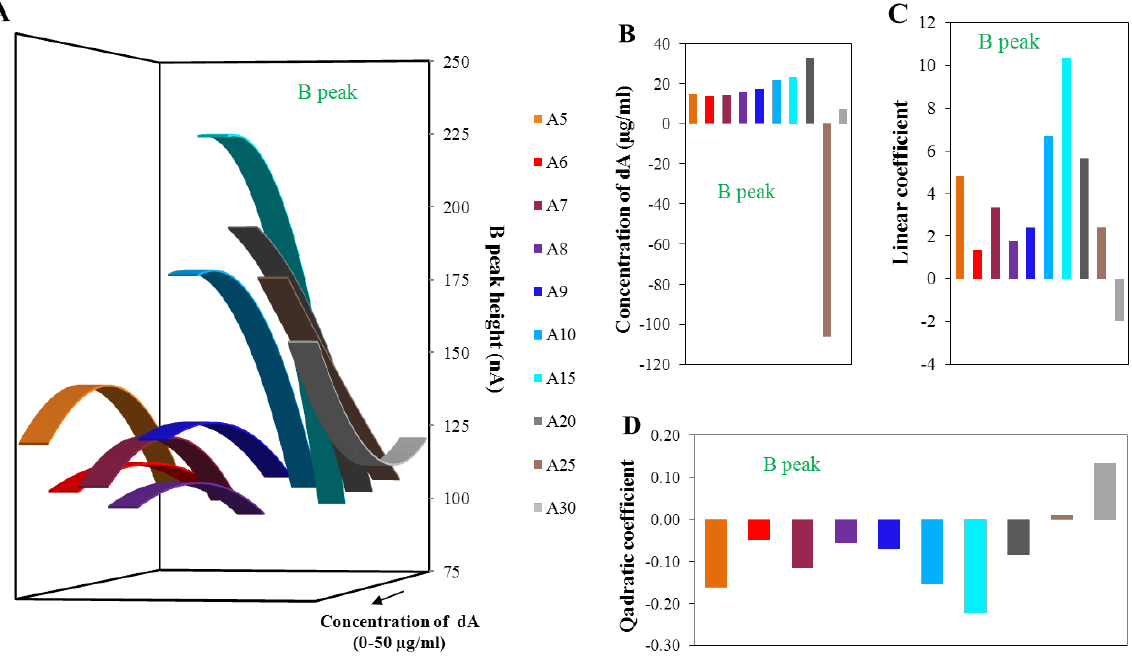
Figure 5. ( A ) Dependence of intensity of peak B related to the applied concentration of adenine nucleotides. The calculated quadratic dependencies are based on the measured data for peak B within the concentration range from 50 ng/mL to 25 µg/mL of adenine nucleotides before isolation process; ( B ) Determined concentration of adenine nucleotides relate to the local maxima/minima of calculated dependencies for peak B after isolation process; not restricted to model concentration interval of adenine nucleotides; ( C ) Dependence of linear coefficient of calculated quadratic dependencies on various number of adenine bases in strand (related to part B); ( D ) Dependence of quadratic coefficient of calculated quadratic dependencies on various number of adenine bases in strand (related to part